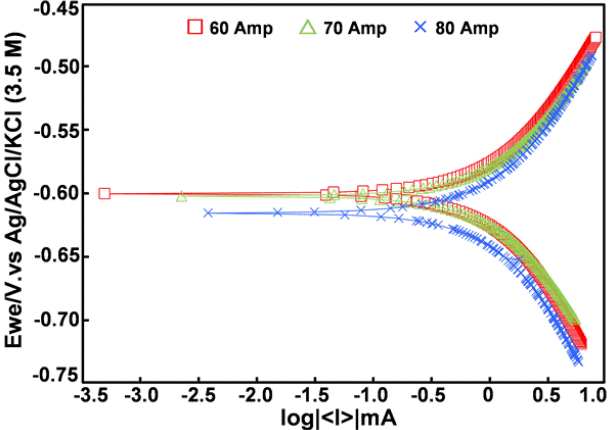
Figure 7. Polarization curve of work-piece welded heat input in welding, and the 0.91, 0.95, 1.04 kJ/mm with test flow rate at 20 L/min .